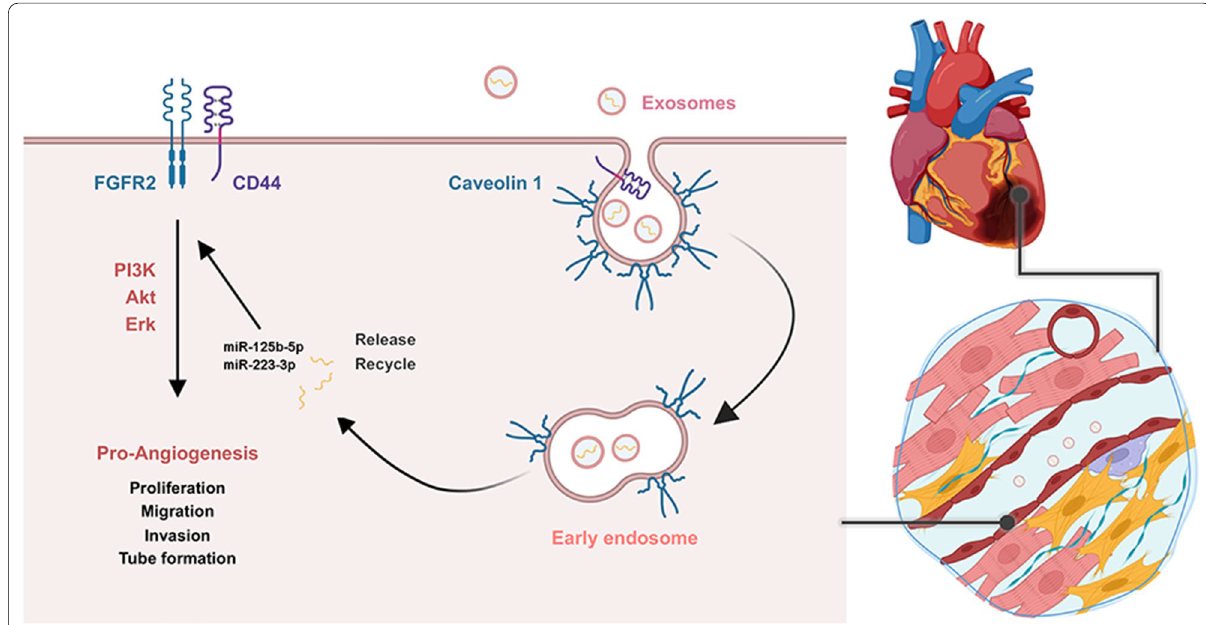
Fig. 7 Schematic diagram of the proangiogenic mechanisms of CD44 in MI. CD44 mediates the activation of the proangiogenic FGFR2 signaling pathway in endothelial cells and regulates the CAV1-dependent uptake of plasma exosomes, of which the contents miR-125b-5p and miR-223-3p enhance the FGFR2 signaling pathway to promote angiogenesis